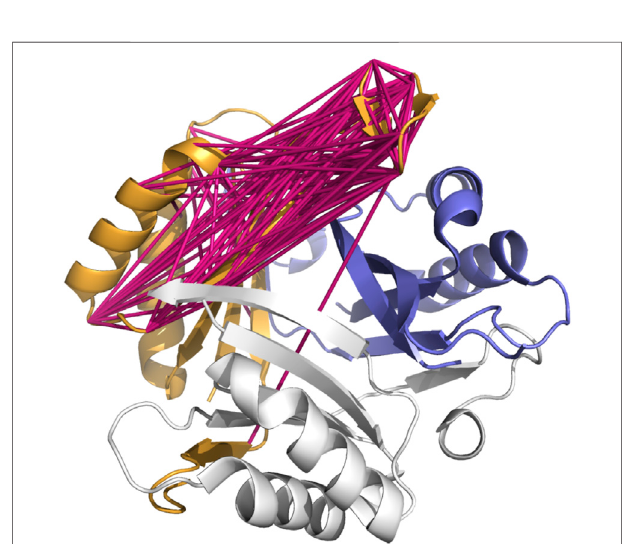
FIGURE 4 | The structure of the homotrimeric functional P-II signal transduction protein, one unit of the trimer shown in orange, one in white, and one in blue. Links are shown in one subunit between the residues selected as co-evolvinginthePfamfamilyPF00543seedalignment.Thebluehelices at the upper right are the blue subunit ’ s copy of the orange helices to the trimeric structure ’ s left. The unexpectedly distant residue pairs seen in Figure 3 may be due to the co-evolution being between the blue subunit and orange subunit, rather than entirely within the orange (or any other single)